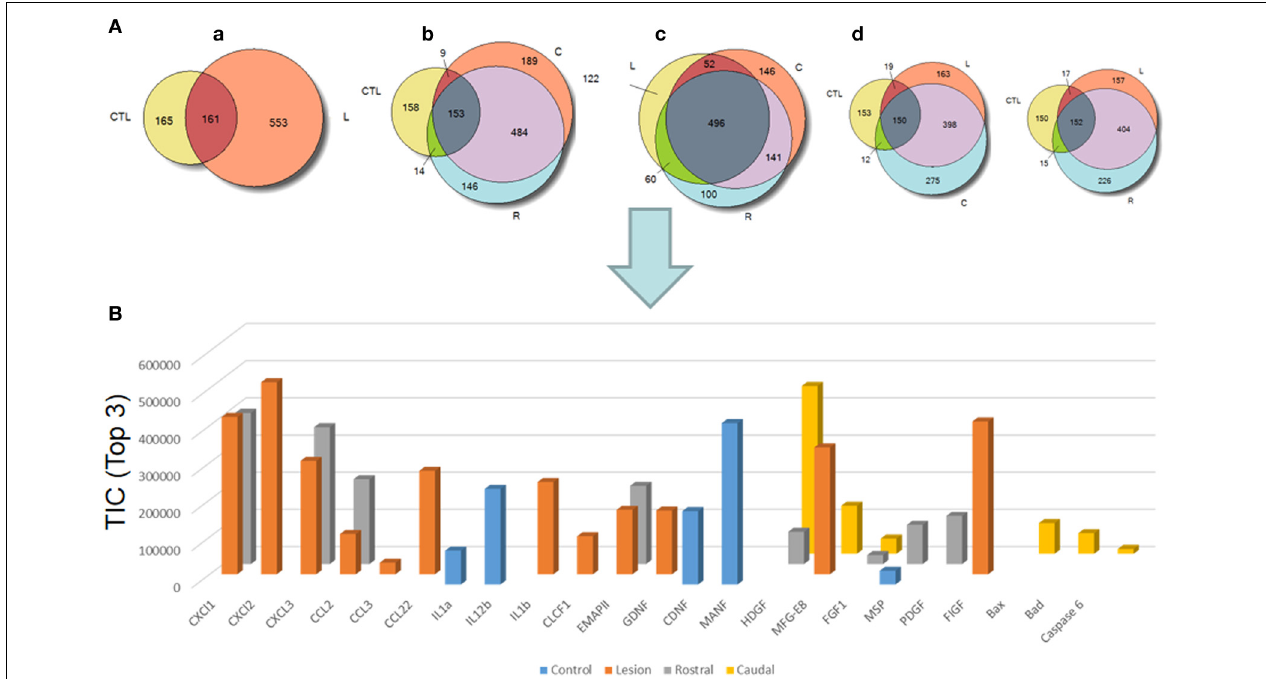
FIGURE 4 | (A) Venn diagram representations of the common identifications after shot-gun analyses between CM derived from rostral, caudal, lesion SCI segments and control spinal cord segments without lesion. (a) consists of a comparison between control (CTL) and lesion (L), (b) Control (CTL), Rostral (R) and Caudal (C), (c) lesion, rostral, caudal and (d) control, lesion, rostral or control, lesion, caudal (see Suppl. data 1–4). (B) Label–free quantification of immune modulators, neurotrophic, and growth factors and apoptotic molecules identified in control, rostral,